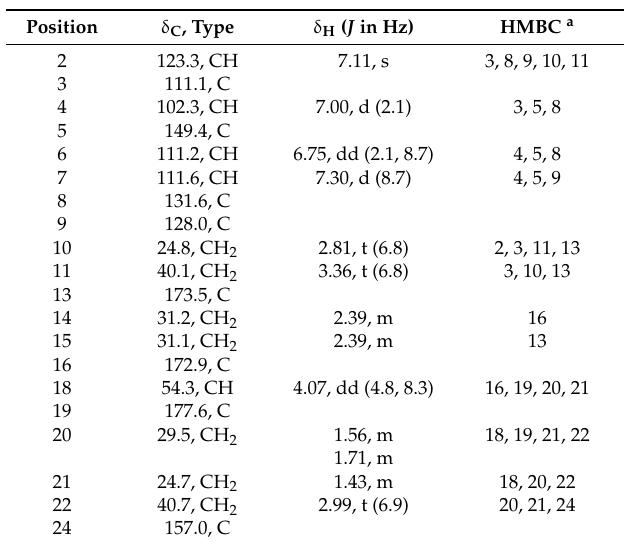
Table 1. The 1 H-NMR (600 MHz, D 2 O), 13 C-NMR (150 MHz, CD 3 OD) spectroscopic data for bufobutarginine ( 1 ) with HMBC